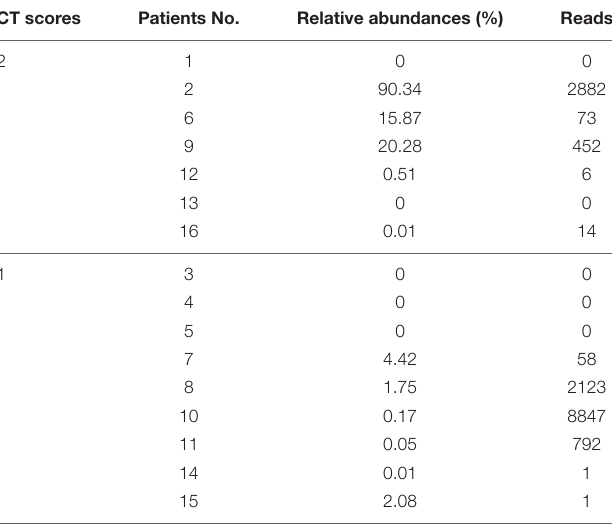
TABLE 4 | Relative abundances of Aspergillus in patients with different CT scores.